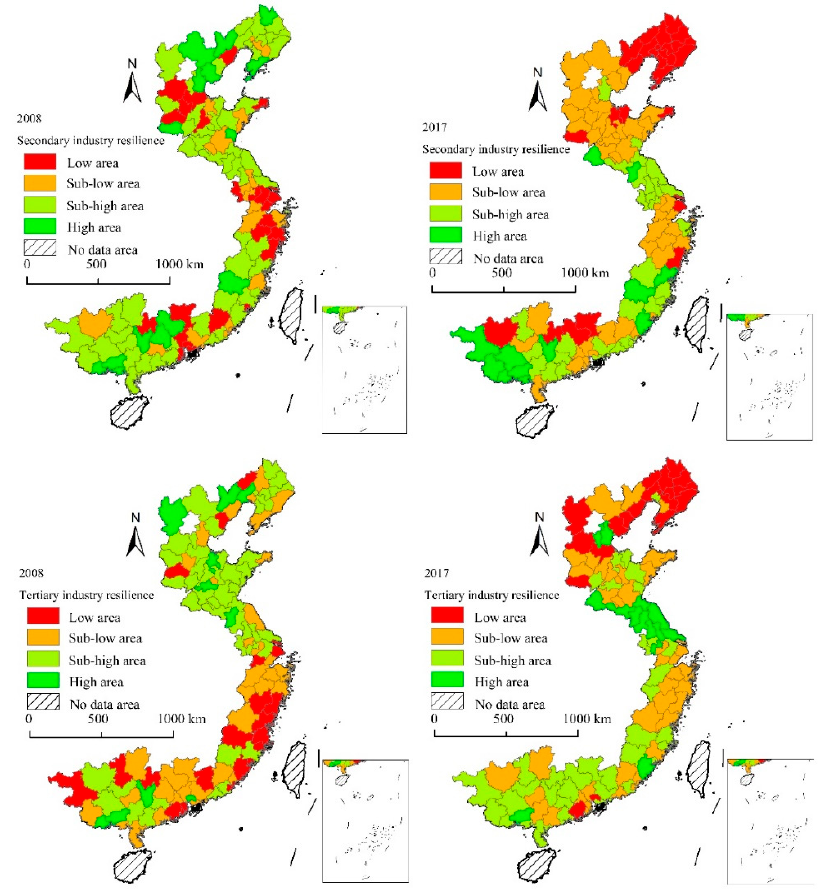
Figure 6. Resilience of secondary and tertiary industries coastal areas in China.